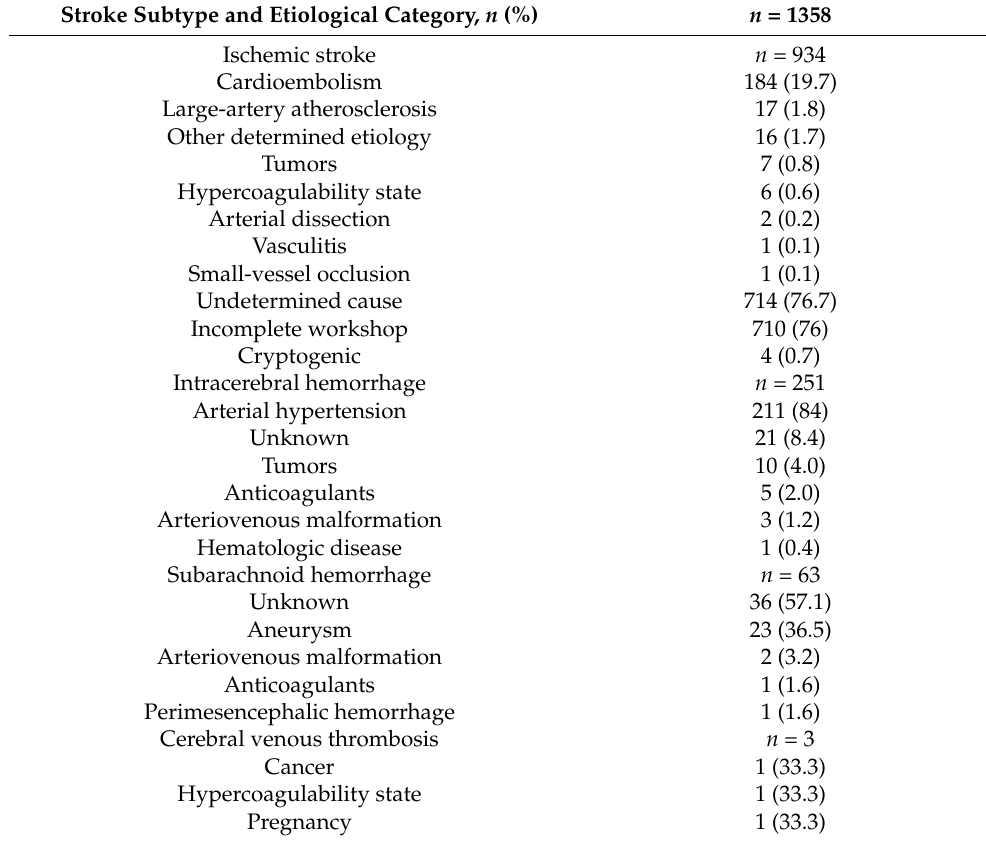
Table 2. Stroke subtypes and